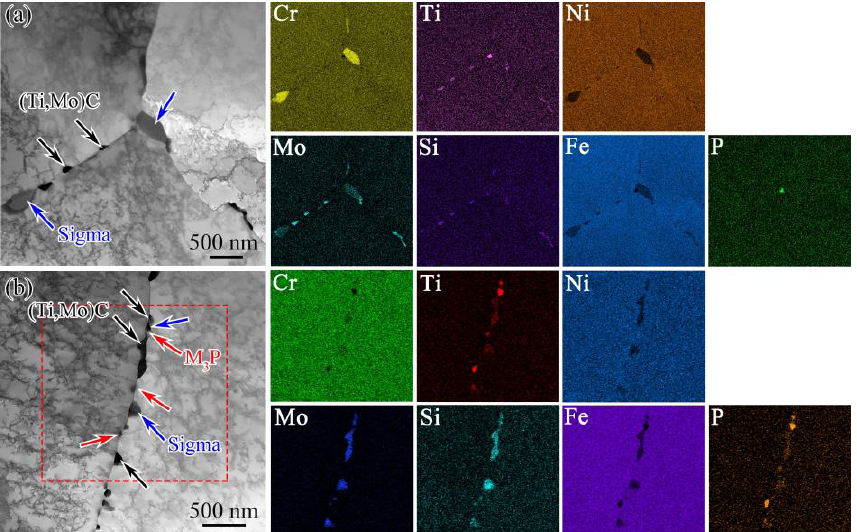
Figure 13. The TEM images near fracture surface of 15Cr–15Ni–Ti–xP alloy after stress rupture testing at 650 °C/195 MPa: ( a ) 15Cr–15Ni–Ti–70P alloy and ( b ) 15Cr–15Ni–Ti–250P alloy.